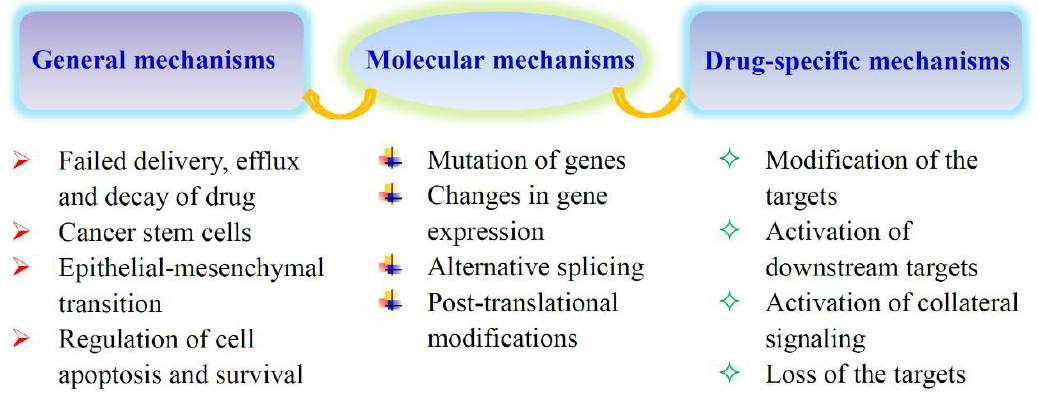
Figure 1. Mechanisms of acquired tumor drug resistance. Some of the reasons for acquired drug resistance are common to many drugs, and others may be drug-specific or pathway-specific. They are all related to the expression and function of specific genes. The pathway-specific mechanisms usually involve the restoration of the tumor-driving signaling pathway.